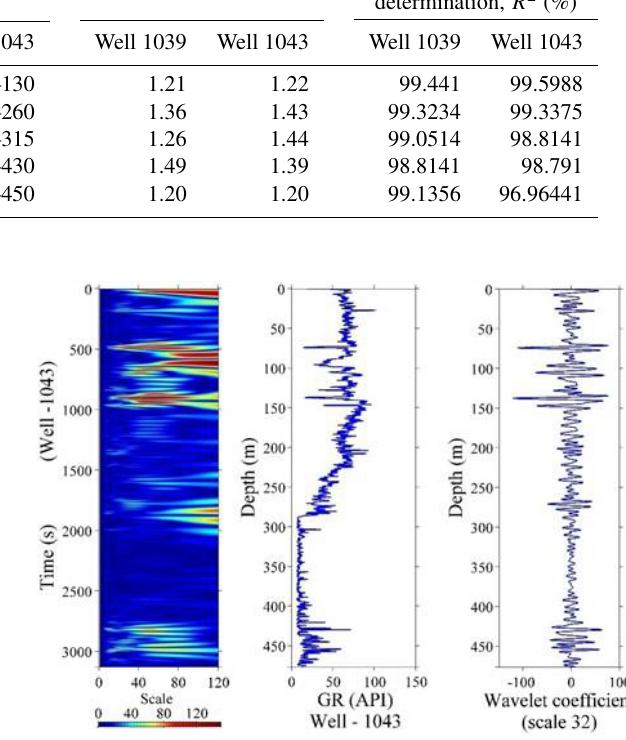
Figure 7. Continuous wavelet transform (CWT) using gamma ray signal and the wavelet coefficient at scale 32 of the gamma ray log of well site